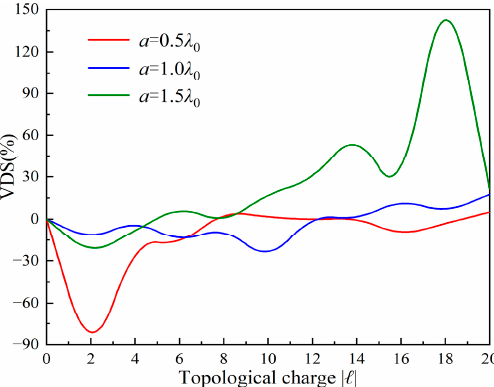
Figure 5. VDS spectra of a dielectric chiral sphere induced by an LG twisted light with different